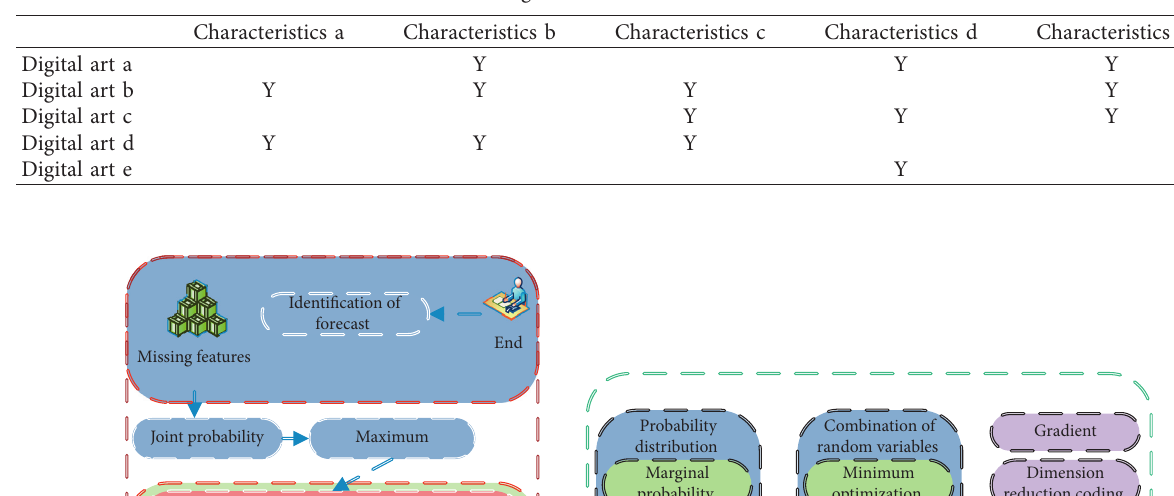
Table 3: Digital art feature attribute data matrix.